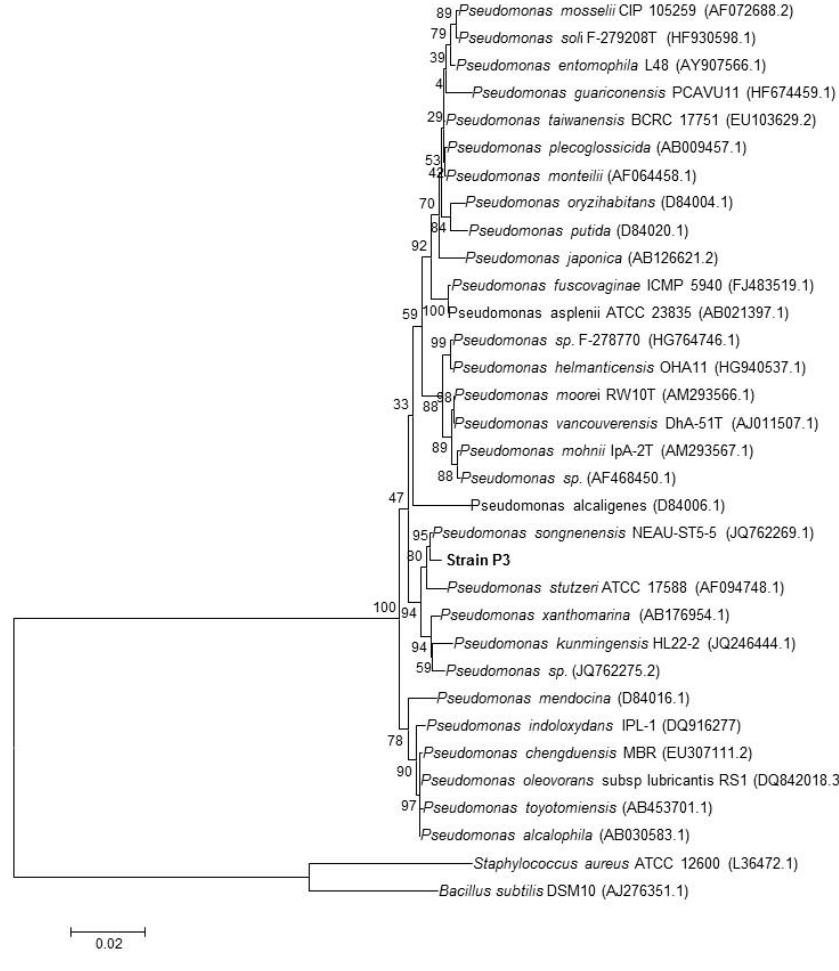
Figure 2. Neighbor-joining phylogenetic tree based on 16S rRNA gene sequences, showing the nearest neighbors of strain P3. Bacillus subtilis and Staphylococcus aureus type strains were used as an outgroup. Bootstrap values (expressed as percentages generated from 1000 replicates) greater than 50% are shown at branch points. GenBank accession numbers are given in parentheses. The bar represents 0.02 substitutions per site.